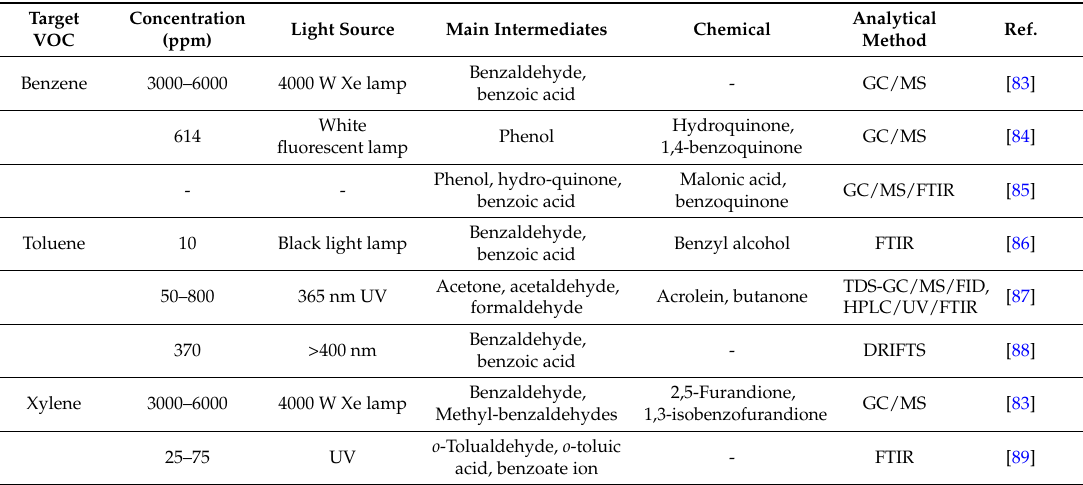
Table 3. Summary on the intermediates formed in photocatalytic oxidation of typical indoor